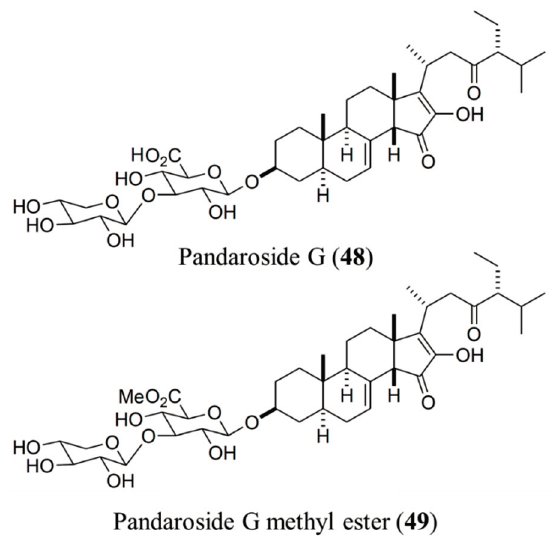
Figure 10. Pandaroside G ( 48 ) and pandaroside G methyl ester ( 49 ), isolated from the sponge, Pandaros acanthifolium [78].